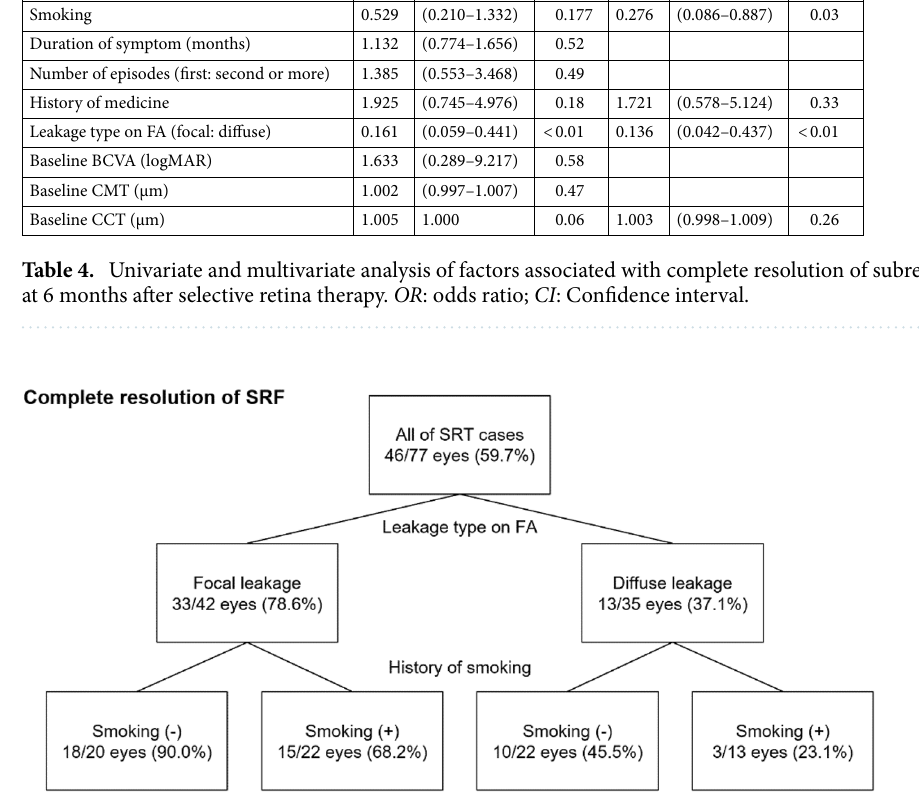
Figure 6. Decision tree classified by the factors associated with the complete resolution of subretinal fluid (SRF). In this study, the overall complete resolution of SRF within 6 months after SRT was 46 out of 77 cases (59.7%). For patients with focal leakage on FA (n = 42), the complete resolution of SRF was seen in 33 cases (78.6%) whereas those with diffuse leakage (n = 35) that was seen in 13 cases (37.1%). For the non-smoker patients with focal leakage (n = 20), complete resolution of SRF was seen in 18 cases (90.0%), whereas for the smoker patients (n = 22) that was seen in 15 cases (68.2%). For the non-smoker patients with diffuse